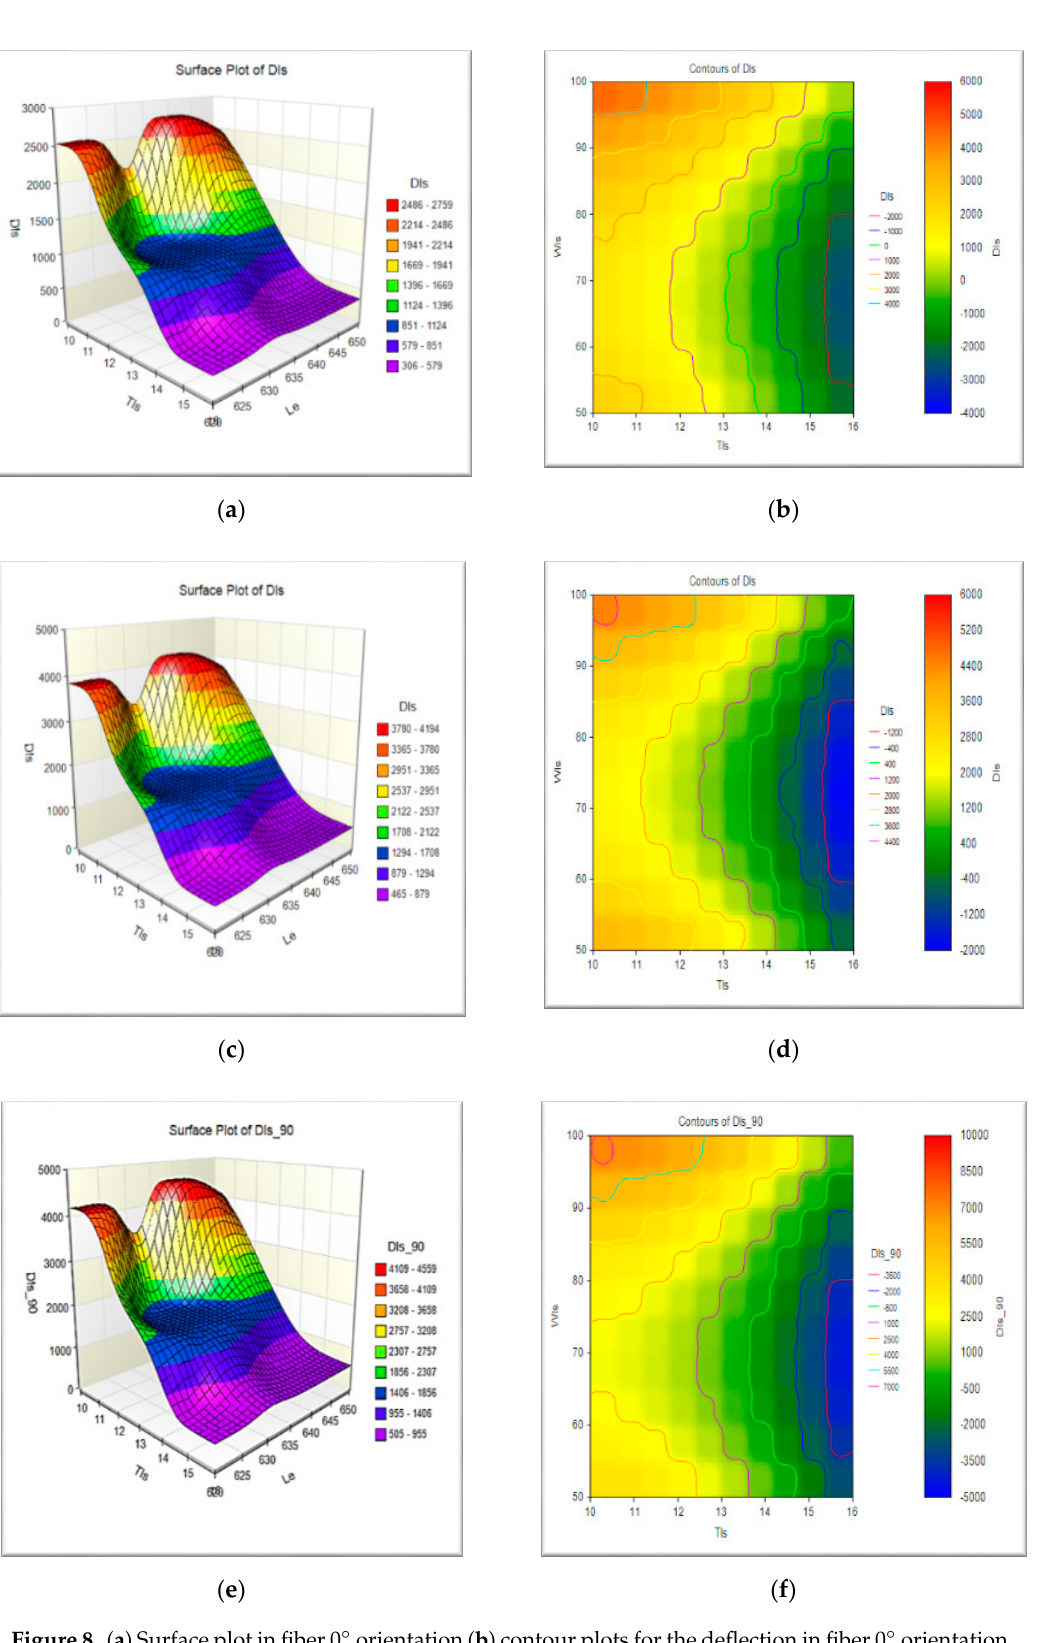
Figure 8. ( a ) Surface plot in fiber 0° orientation ( b ) contour plots for the deflection in fiber 0° orientation, ( c ) surface plot in fiber 45° orientation ( d ) contour plots for the deflection in fiber 45° orientation, ( e ) surface plot in fiber 90° orientation (f) contour plots for the deflection in fiber 90° orientation.